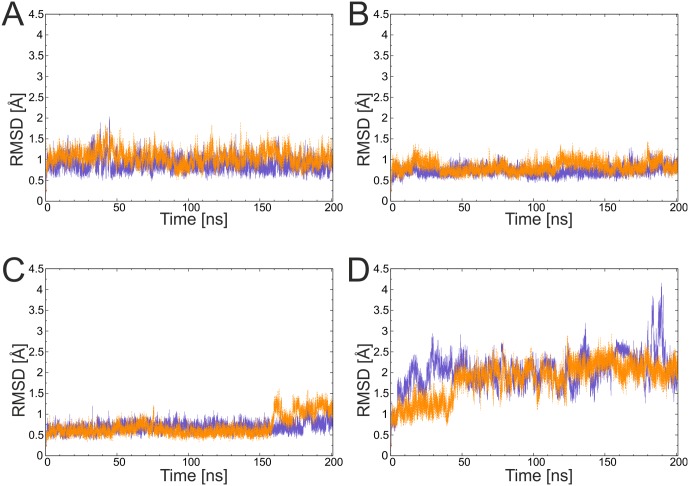
Conformational stability of the parent domains (violet) and tag/catcher (orange) constructs deduced from the molecular dynamics simulations.(A) 3phs, (B) 4oq1, (C) 3kptN, and (D) 3kptC. The RMSD was calculated for the backbone of the residues forming the core of the domains (see Methods for a definition of the core residues).